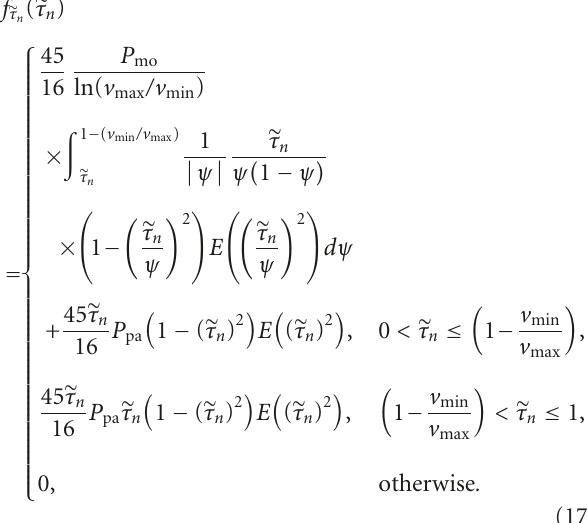
plots, obtained by simulation are given in Figures 10 and 12,